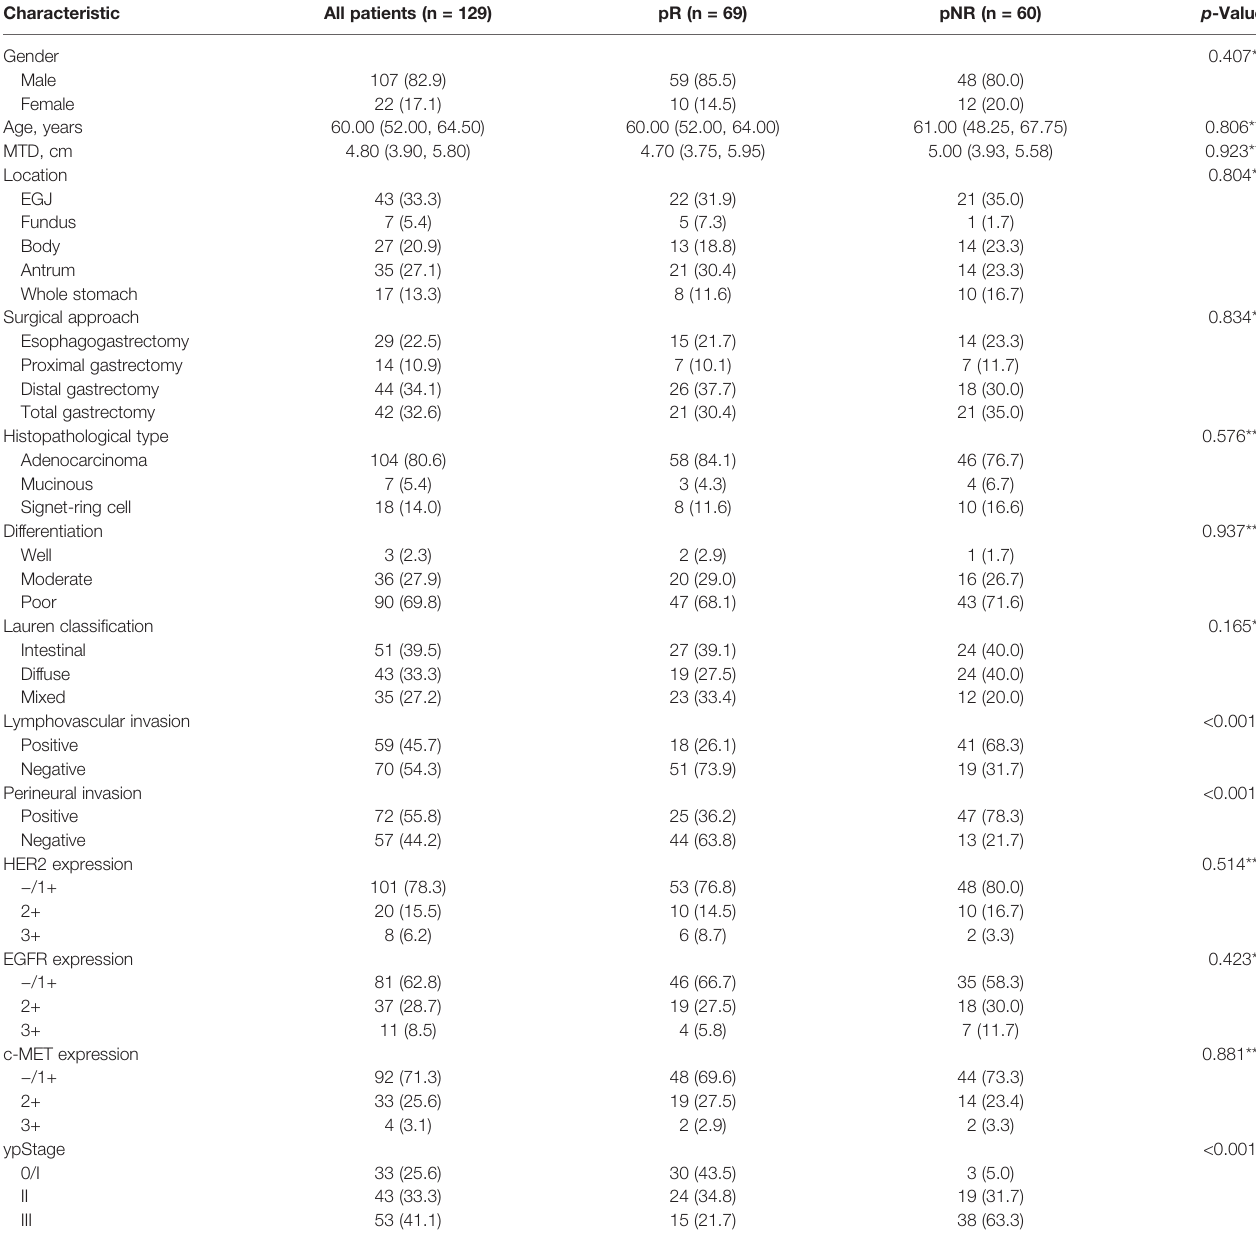
TABLE 1 | Clinical and histopathological characteristics of 129 patients in pR and pNR groups. Characteristic All patients (n =